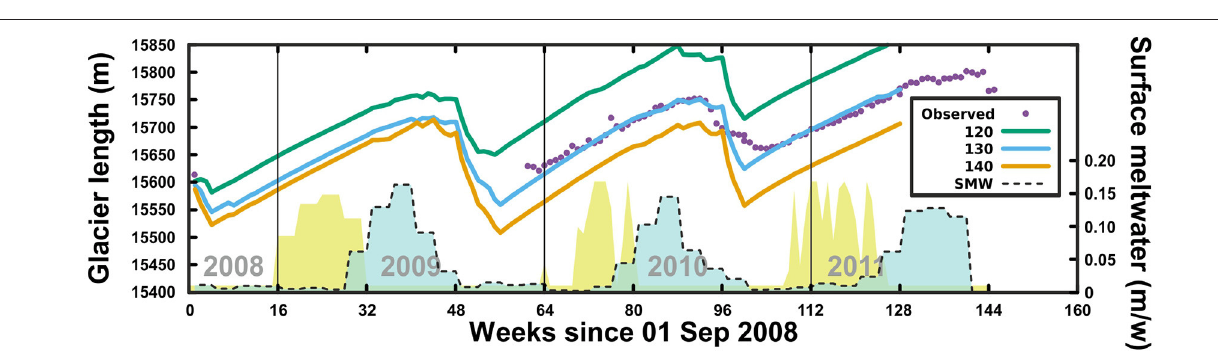
FIGURE 8 | Modeled glacier length for crevasse water depths parameterized as a linear function of the available surface meltwater for a range of values of the linear coefficient k (shown in box), with an ice mélange backstress of 50 kPa. Magenta dots represent the observed glacier lengths. The dashed line indicates the modeled surface meltwater near the calving front. Yellow shaded areas represent the observed ice mélange coverage in the glacier forebay. Week means here 1/48 of a